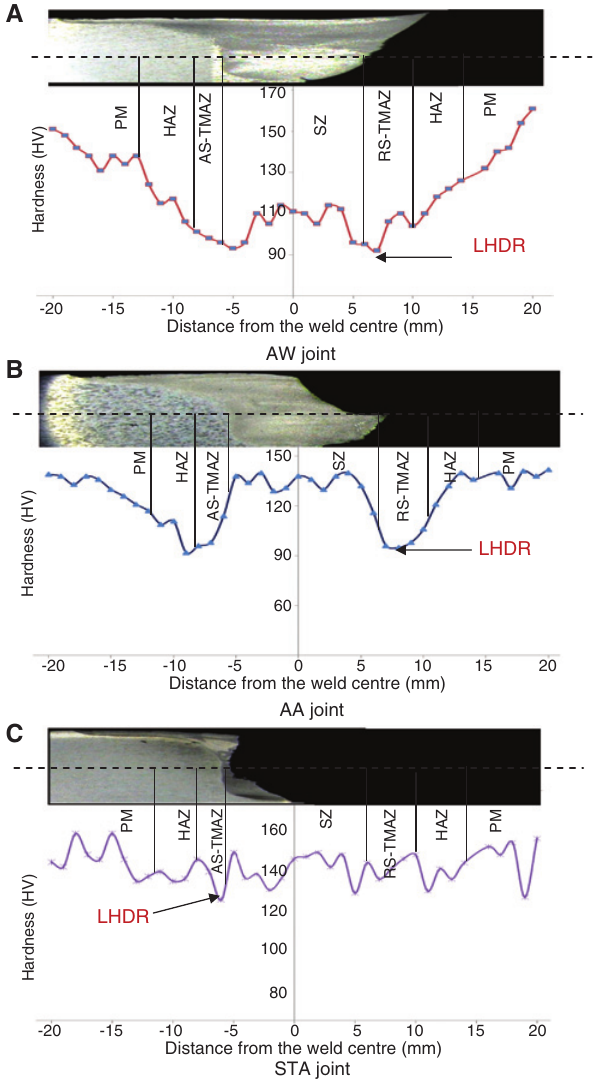
Figure 3: Microhardness distribution (LHDR: lowest hardness distribution